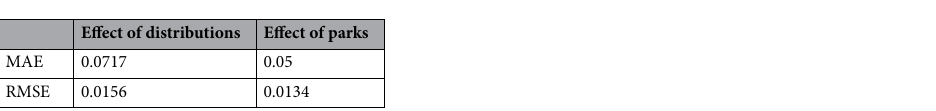
Table 7. The p values of the Friedman test for interval wind speed